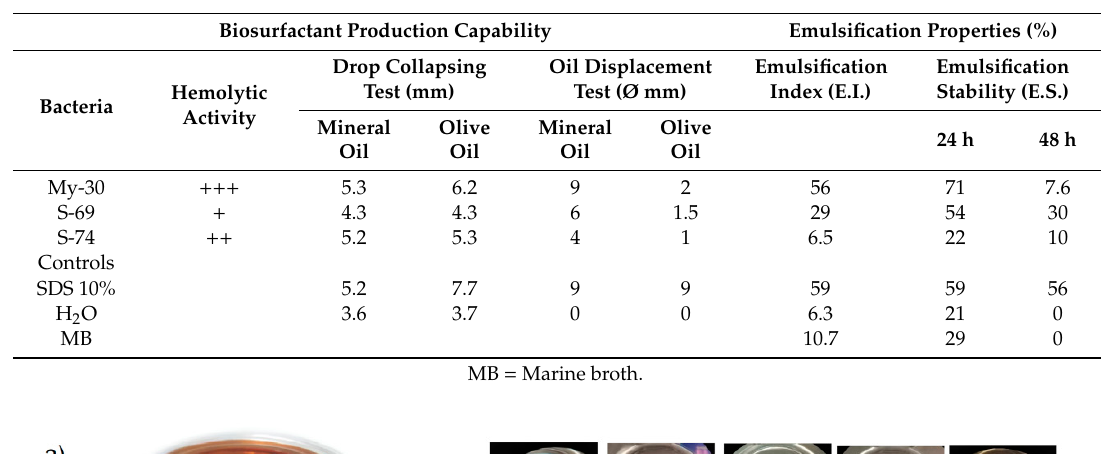
Table 2. Capability of marine bacteria isolated from the Gulf of California to produce biosurfactants with drop collapsing and emulsification properties.